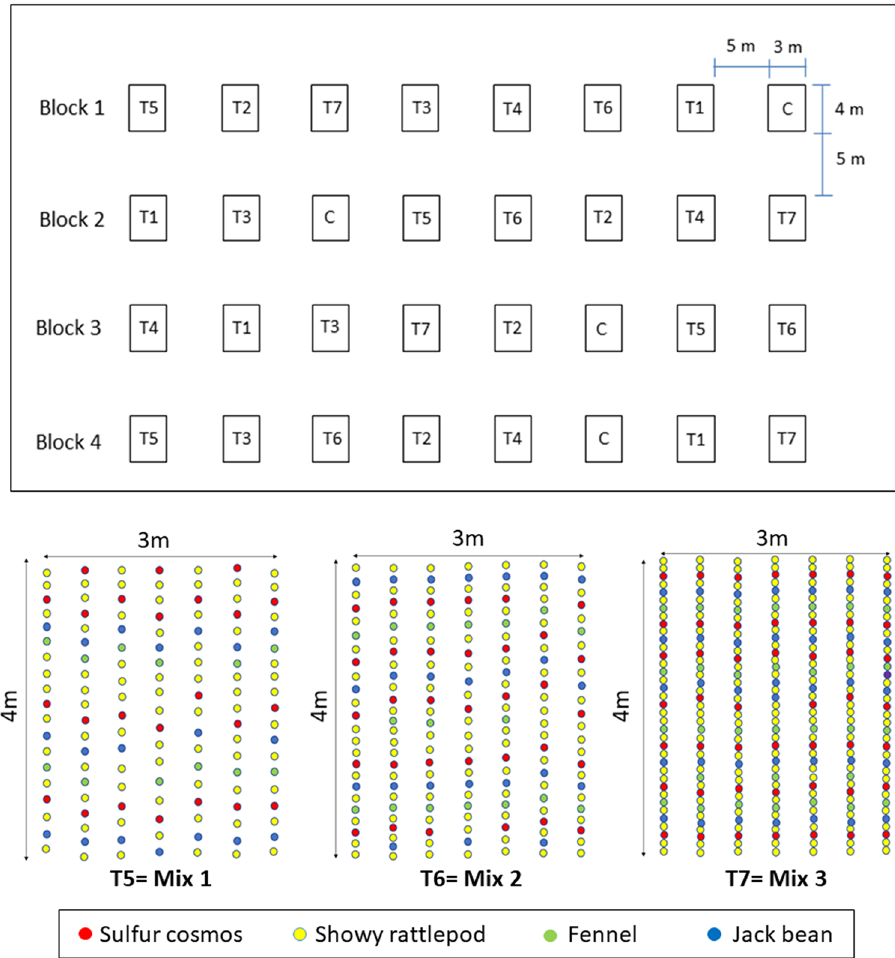
Figure 1. Experimental design. Seropédica, RJ, Brazil, May to November 2017. Treatments: T1: sulfur cosmos; T2: showy rattlepod; T3: fennel; T4: jack bean; T5: mix a 1; T6: mix 2; T7: mix 3; C: control. a Mix 1, 2, and 3 represent the intercropping of sulfur cosmos, showy rattlepod, fennel, and jack bean in three cultivation densities 10.8, 14.3, and 21.5 plants m −2 , respectively.